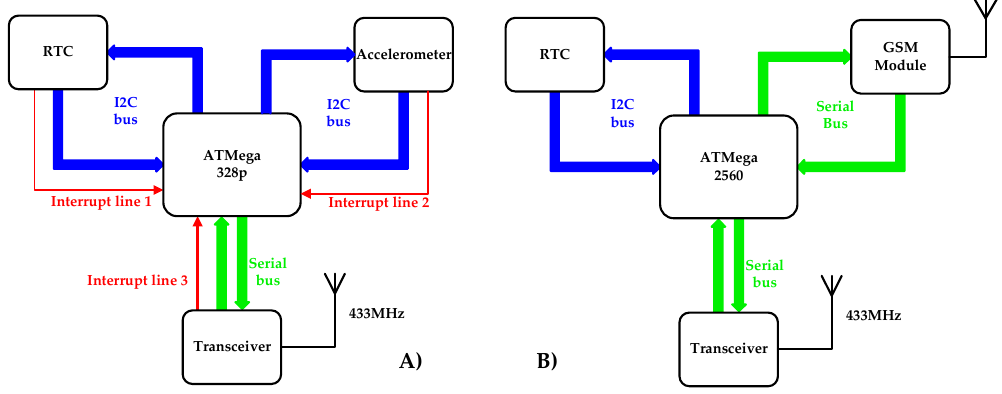
Figure 1. Node/repeater ( A ) and data logger ( B ) block